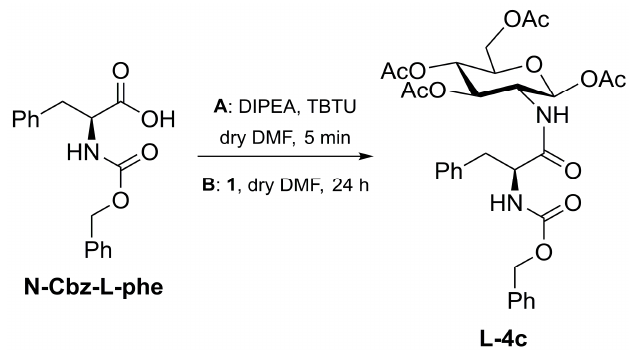
Figure 5. Synthesis of L-4c by means of TBTU/DIPEA coupling. DIPEA is used in excess with respect to the amino acid in order to evaluate a possible racemization. Table 2. Specifics for N -Cbz- L -phe and 1 coupling in the presence of TBTU/DIPEA. T R = reaction